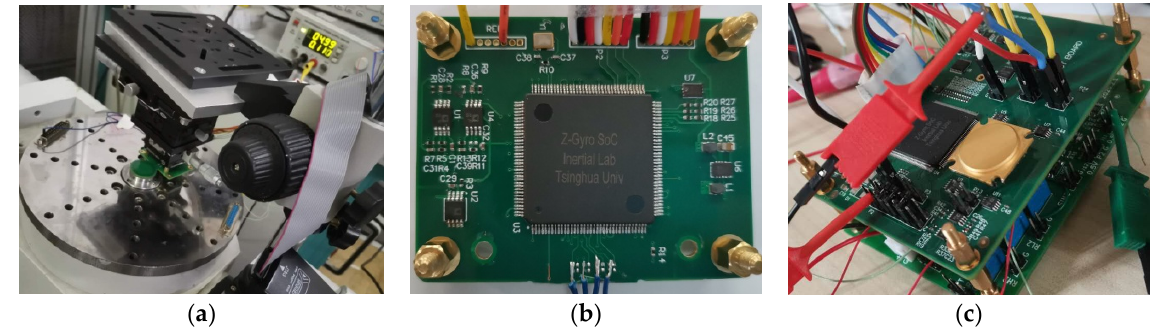
Figure 9. The testing site and testing boards. ( a ) Equipments for function testing; ( b ) step test of an angular displacement sensor; ( c ) frequency sweep experiment of a MEMS